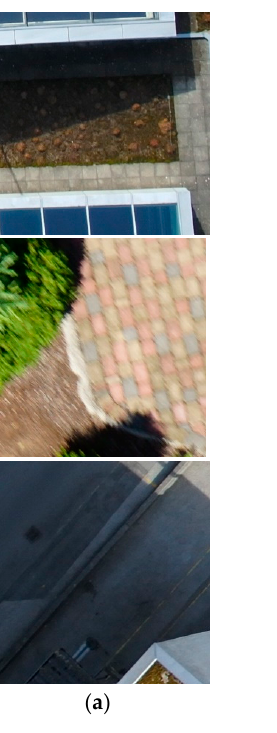
Figure 7. Visual comparison of thresholding method for Test Image 1 (row 1), Test Image 2 (row 2), and Test Image 3 (row 3). ( a ) input image, ( b ) ground truth, ( c ) manual thresholding, and ( d ) Otsu’s thresholding. The outputs using Otsu’s thresholding are comparable to the results using manual thresholding.